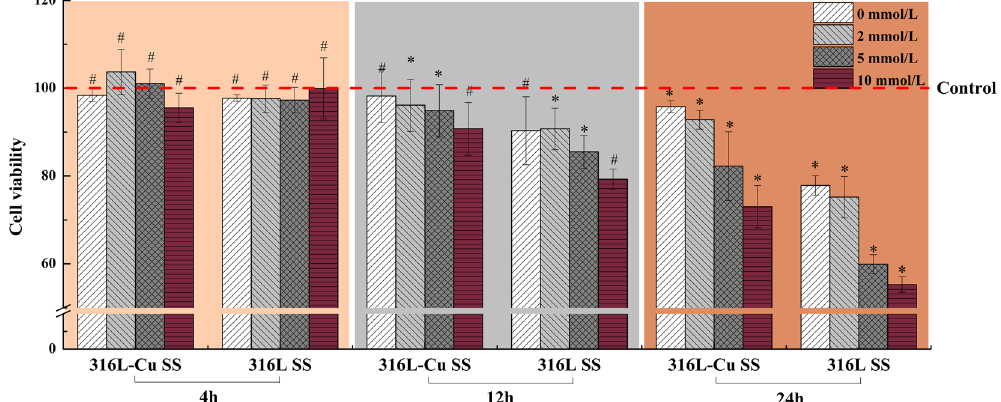
Figure 1. Viability of UECs incubated with different extracts plus various concentrations of oxalate (0, 2, 5 or 10 mM) and COM (200 μ g/ml) for 4 h, 12 h and 24 h, respectively. The cells viability was determined using a MTS kit according to the product protocol. The data shown are the mean and standard deviation (SD) (N = 5). * Indicates a significant difference at p < 0.05 ( * p < 0.05), and # indicates no significant difference at p > 0.05 ( # p > 0.05) compared to 316L SS incubated for the same